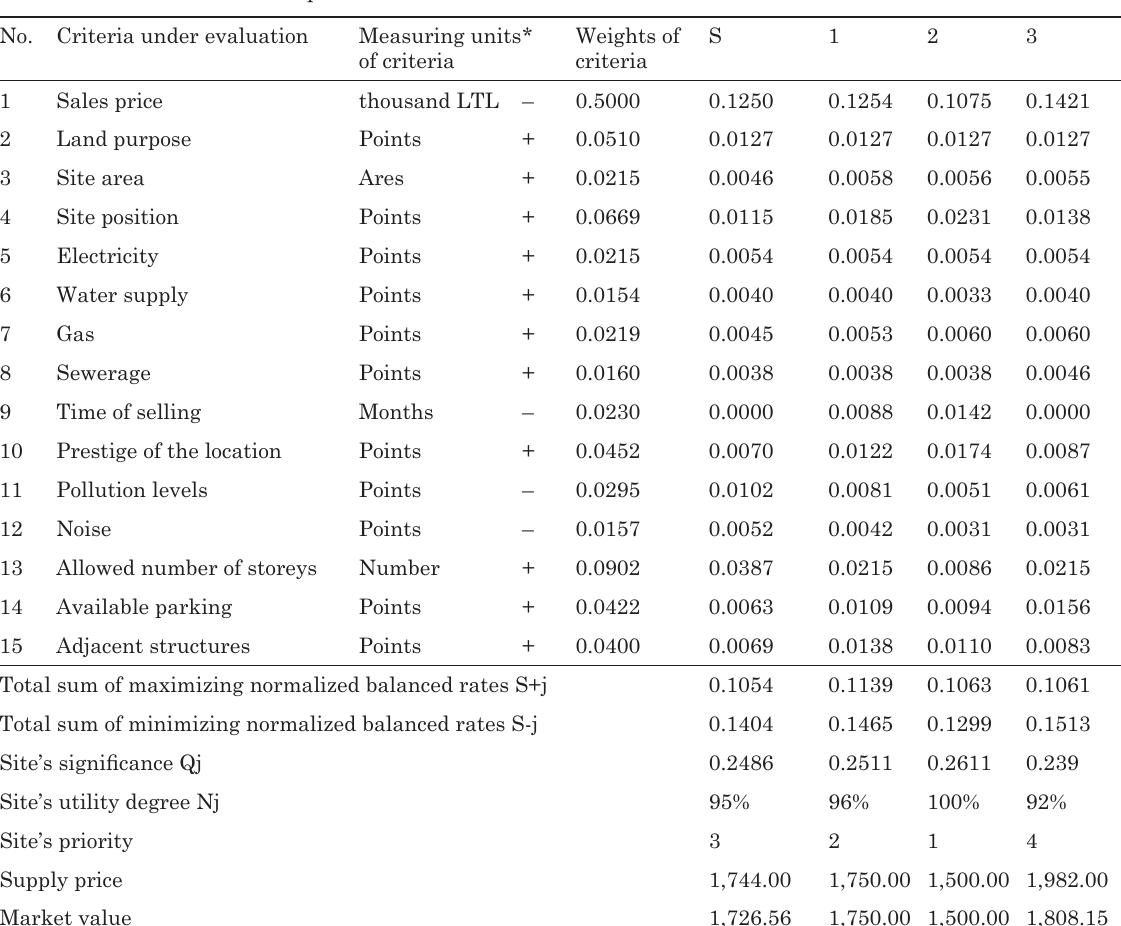
table 2. the results of multiple criteria evaluation